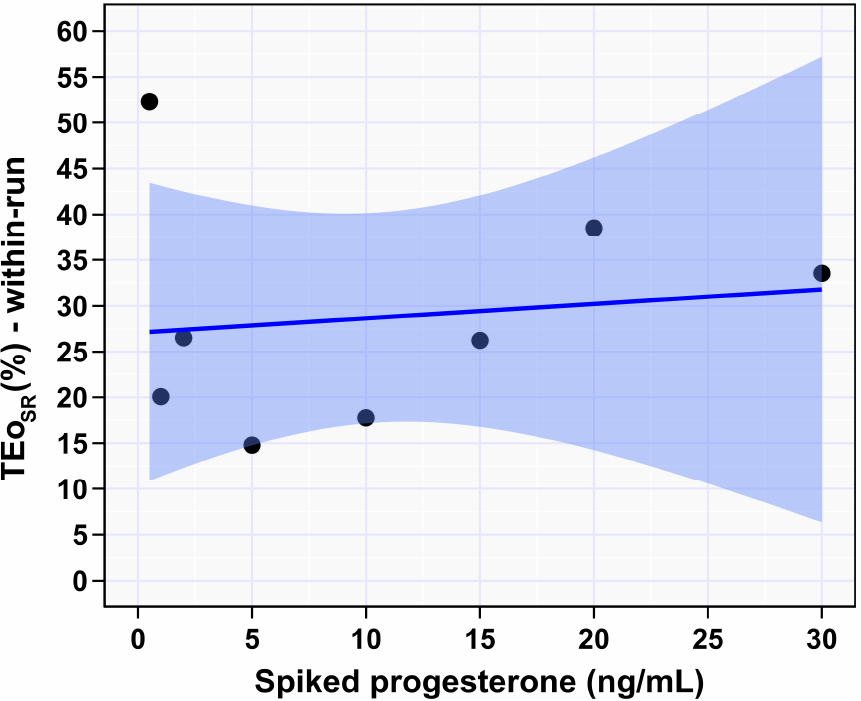
Figure 6. Observed total error percentage (TEo) of IMMULITE ® 2000 XPi progesterone immunoassay across the spiked serum. The shaded blue area indicates 95% CI of the mean difference. The dark solid blue line indicates the fitted regression line.